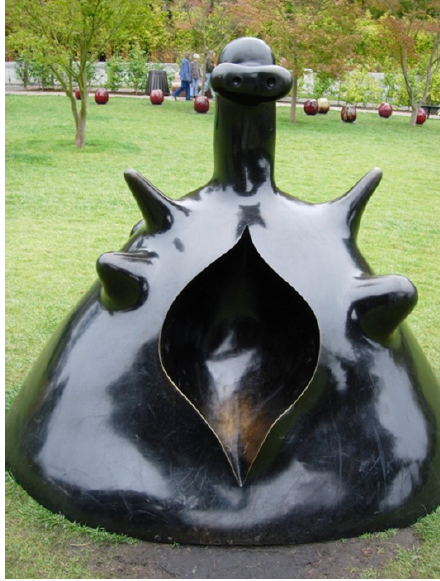
Figure 5. Joan Miró, Grande Maternité, 1973 . Photo by Soonsoon, 2007, licensed under Creative Figure 5. Joan Mir ó , Grande Maternit é , 1973. Photo by Soonsoon, 2007, licensed under Creative Commons: CC BY-SA 3.0 . Commons: CC BY-SA